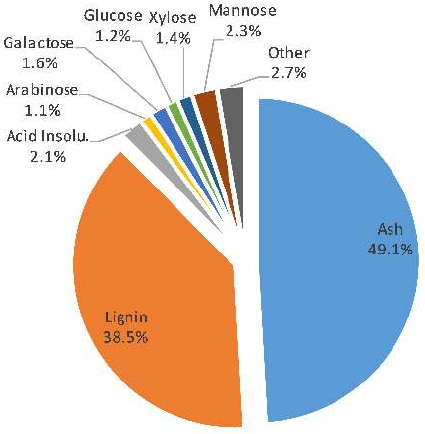
Figure 2. Composition of the untreated spent-sulfite-liquor raw material.